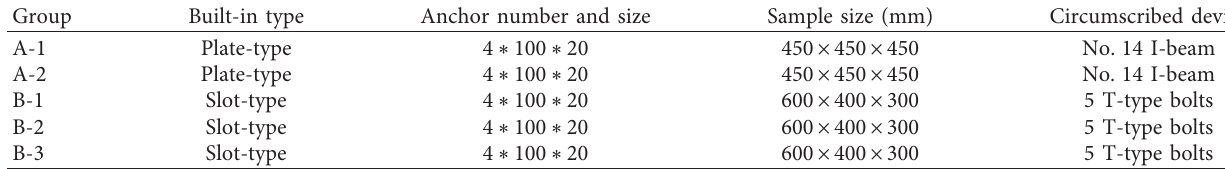
Table 1: Specimen parameters for A and B groups.